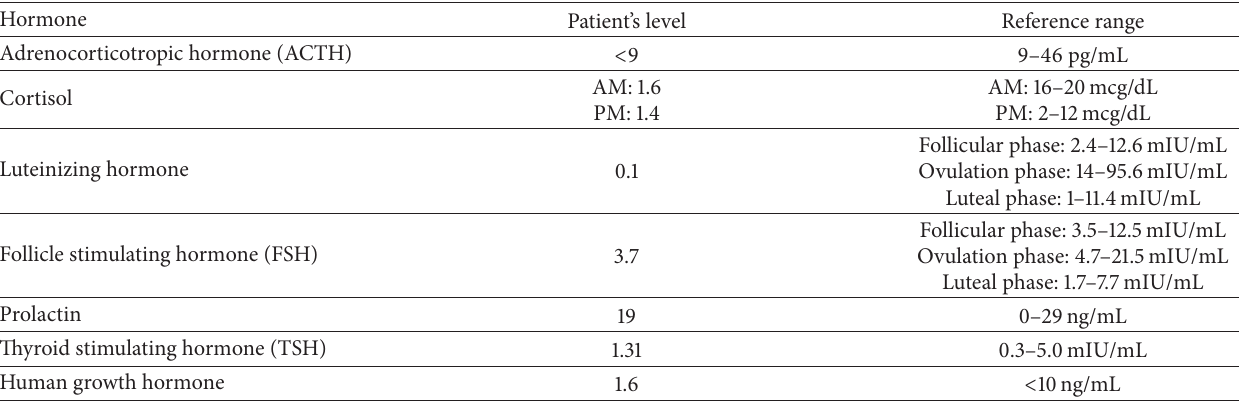
Figure1:(a)2.4 × 2.2 cmenhancingsellarlesion,coronalsection.(b)Asagittalsectionofthesamesellarmasswitha1.5 cmtertiarydimension. Table 1: Results of the pituitary axis hormone levels of the